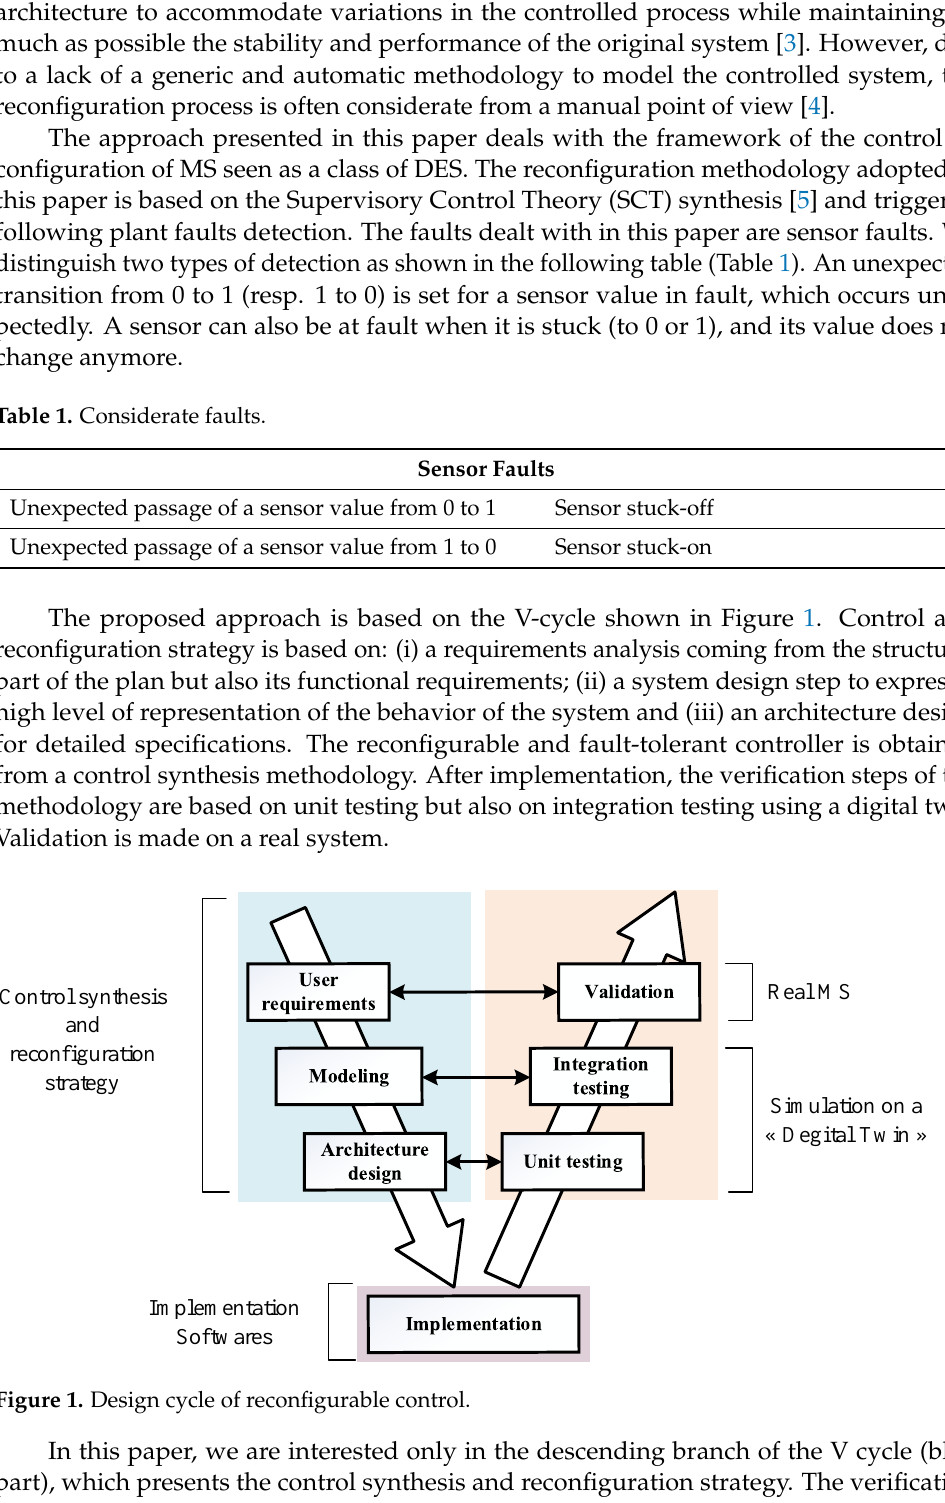
Table 1. Considerate faults.